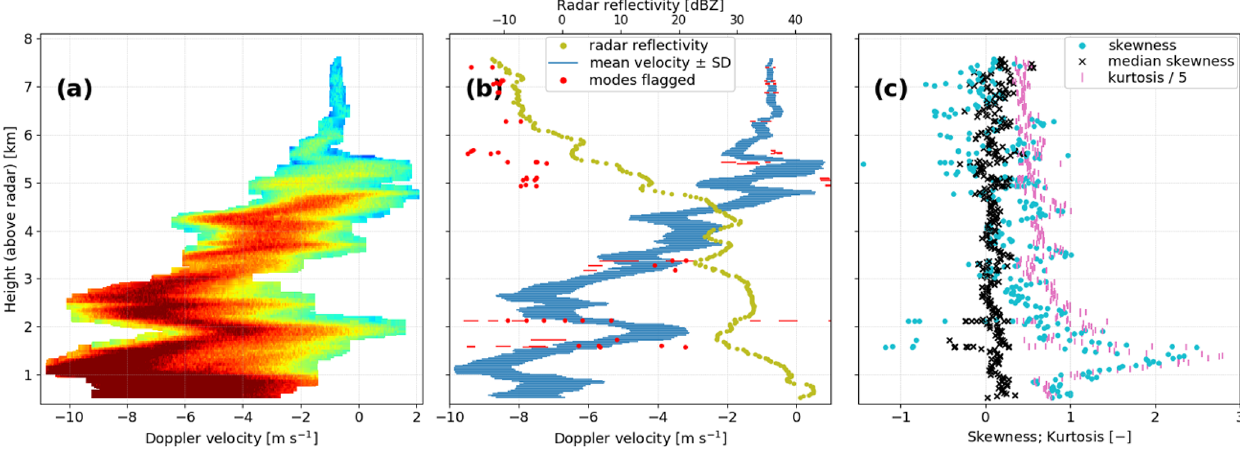
Figure 12. Summary of analysis results for a birdbath scan recorded in intense frontal rain at DWD’s Dresden (DRS) radar in July 2021 (data timestamp: 11 July 2021, 15:59:16UTC), analogous to Figs. 8, 10, and